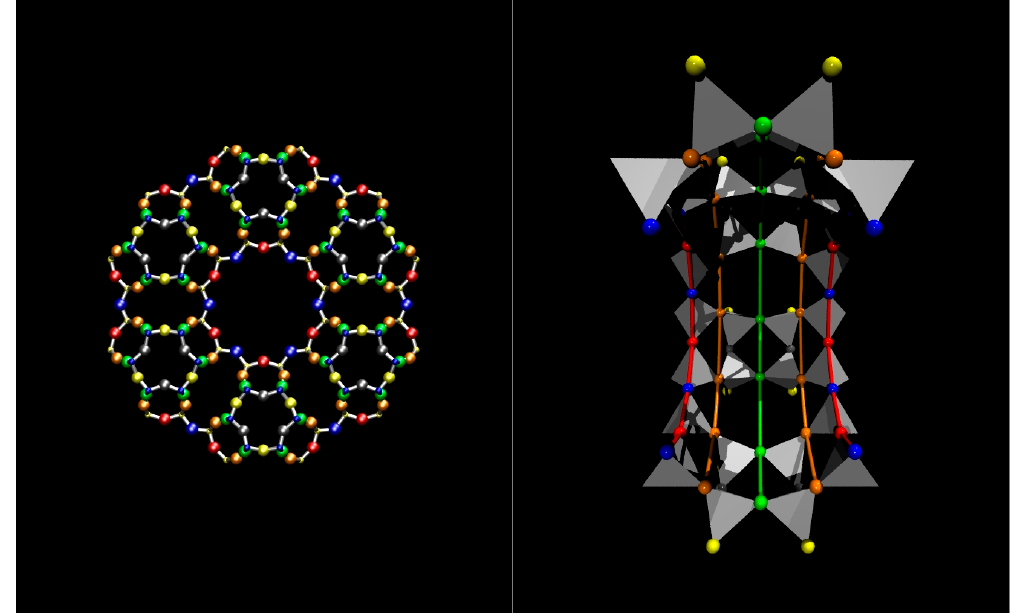
Figure 1. Zeolite L and its one-dimensional nanochannels. Left panel: View along the channel axis (parallel to [001]) highlighting the larger channel, delimited by a 12-membered ring (12 MR) and surrounded by smaller 8 MR channels. The tetrahedral atoms of the framework (T = Si, Al) are represented by small balls, O atoms by big balls. Colour codes: T1 = yellow, T2 = blue, O1 = blue (big), O2 = red, O3 = grey, O4 = orange, O5 = yellow (big), O6 = green; Right panel: Half-section of the 12 MR channel, viewed perpendicular to the 12 MR channel axis. T-atoms (Si, Al) are represented by grey tetrahedra, O atoms by big balls, with same colour codes as in the left panel. The coloured lines are a guide to the eye drawn to represent the different rings in the cage and to evidence the channel curvature under a perspective view.